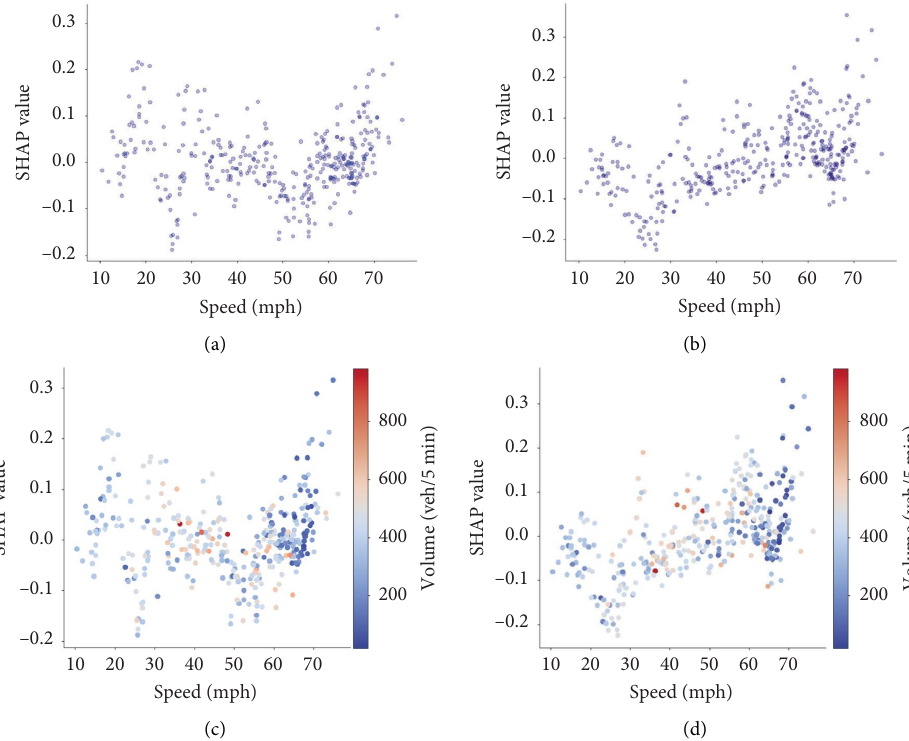
Figure 6: SHAP local dependence plots of speed. (a) Main efects of speed on the time gap. (b) Main efects of speed on the distance gap. (c) Interaction efects between speed and volume on the time gap. (d) Interaction efects between speed and volume on the distance